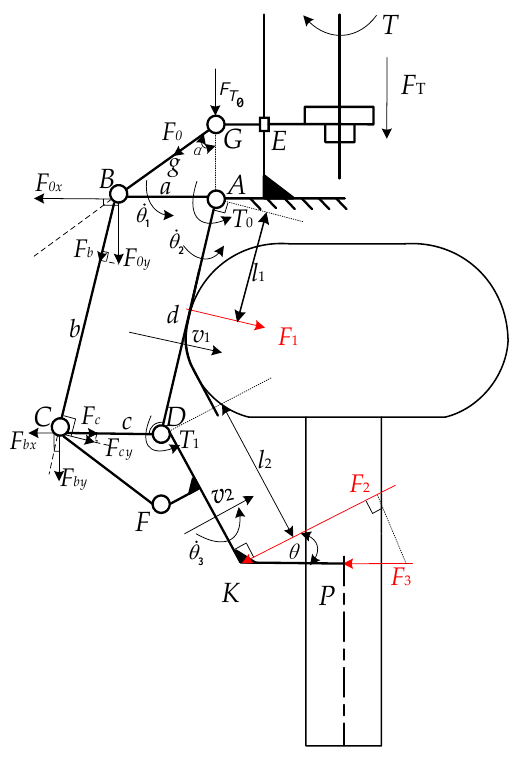
Figure 9. Statics analysis diagram of underactuated mechanism.